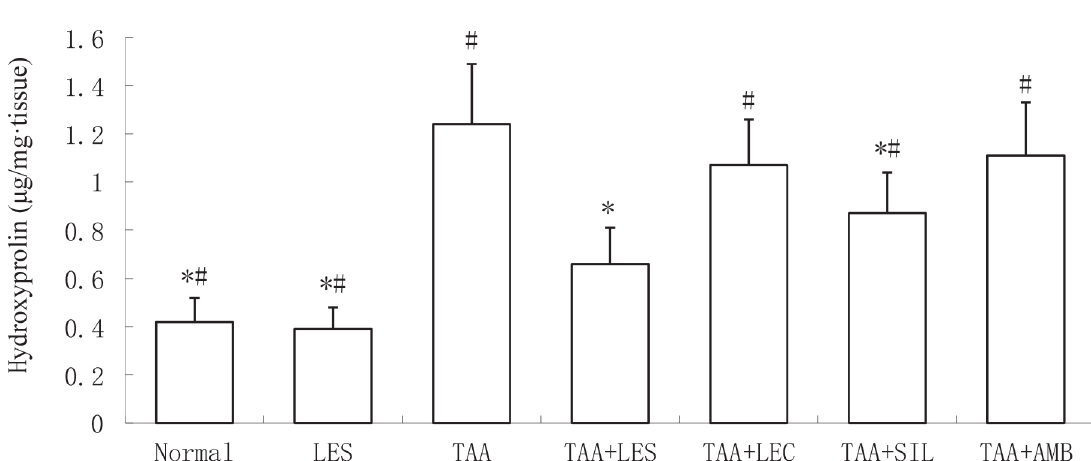
FIGURE 3 - Effect of TAA, lesimarin and its constituents on hydroxyprolin level. The data were stated as mean ± SD. Means with different superscripts are significantly different. * p < 0.05 versus TAA group and # p < 0.05 versus TAA+LES group. LES stands for Lesimarin. TAA stands for thioacetamide. LEC, SIL, AMB stand for lecithin, silymarin, Artemisia messerschmitiana Besser, respectively.